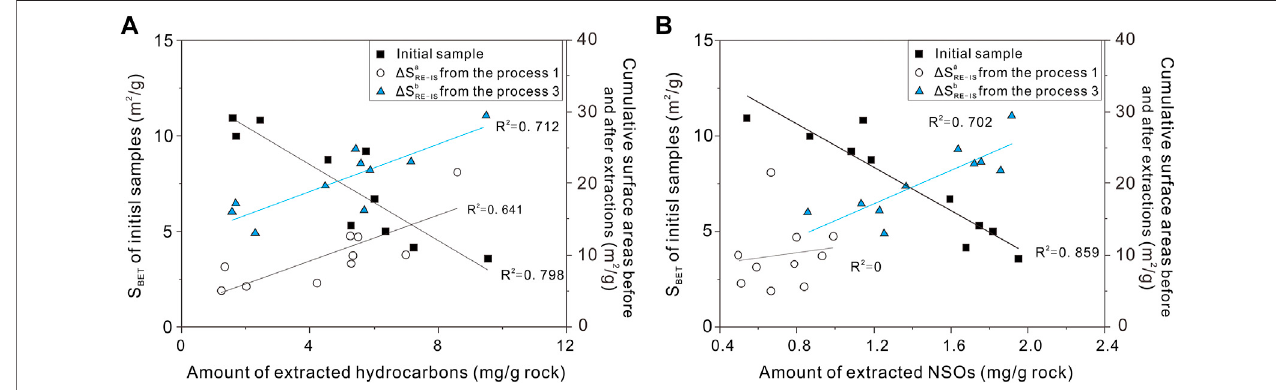
FIGURE8|(A) Amountofhydrocarbonsvs.surfaceareasintheinitialsamplesandcumulativesurfaceareas,respectively; (B) AmountofNSOsvs.surfaceareasin the initial samples and cumulative surface areas, respectively.